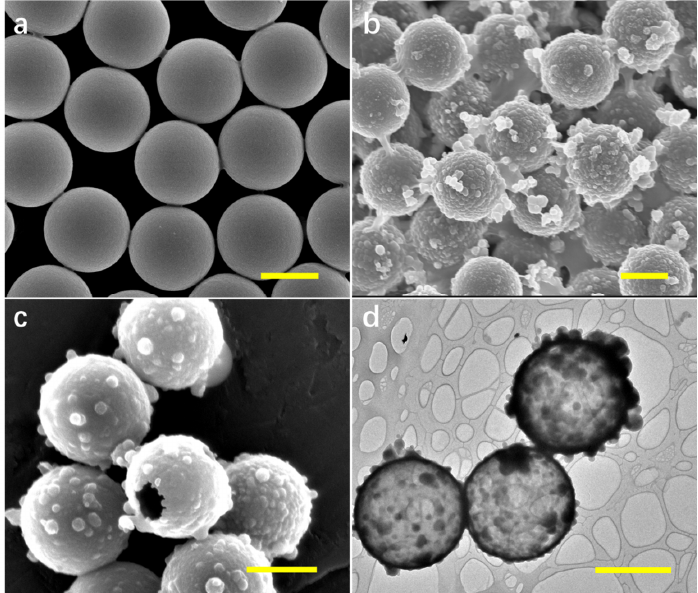
Figure 1. Scanning electron microscopy (SEM) image of ( a ) polystyrene microspheres (PS), ( b ) PS/silicon nanocrystal containing polymer (SiP) composites, and ( c ) hollow SiP microspheres (SiPM) ((3-aminopropyl)-trimethoxysilane (APTES)/ L-ascorbic acid (L-AA): 1/10). ( d ) Transmission electron microscopy (TEM) image of hollow SiPM. Scale bar: 2 µm.